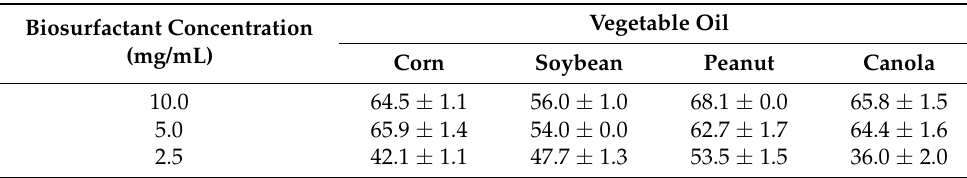
Table 4. Emulsification index (E 24 ) of the biosurfactant produced by B. cereus UCP 1615 for different vegetable oils (data expressed as mean ± SD of the triplicate determinations). Data are expressed in %.